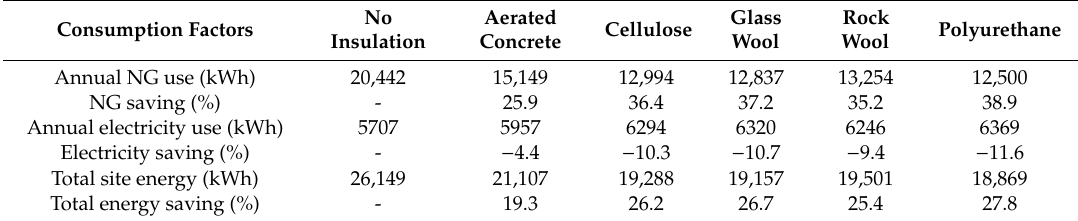
Figure 16. Monthly electricity consumption for different insulation materials. Table 12. The annual energy consumption and energy saving for various insulation